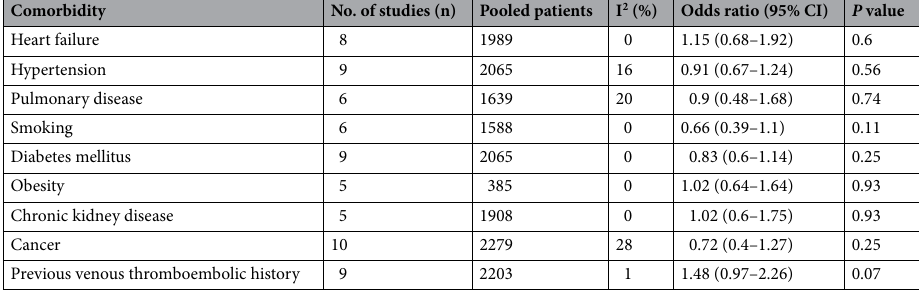
Table 3. Calculated heterogeneity and effect size of potential risk factors for pulmonary embolism* CI, confidence interval. *All studies included were of high